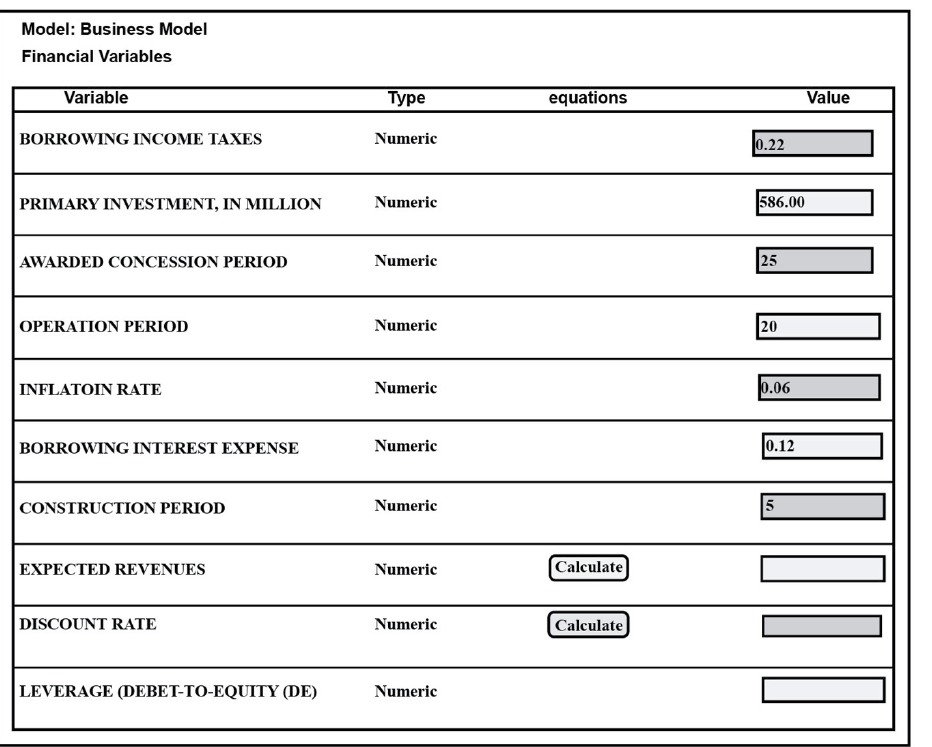
Figure 4. Business data entry sheet by RAA3P